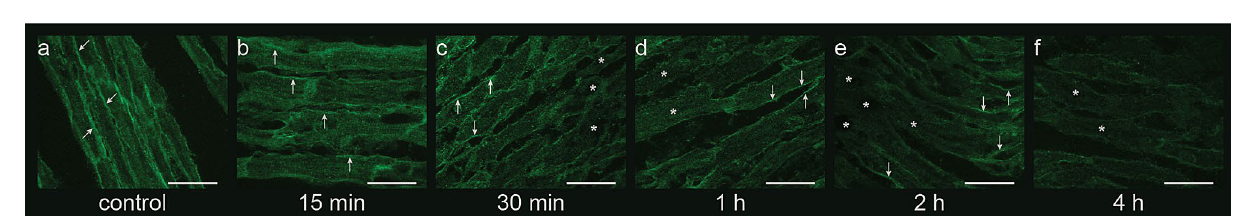
Figure 6. Immunofluorescence for Na v 1.5. ( a ) Expression of Na v 1.5 is evident at the plasma membrane and intercalated disks in the control heart; a fainter cytoplasmic signal was also observed. ( b ) Expression at 15 min of ischemia is similar to control. ( c – f ) Starting 30 min of ischemia, a patchy fainter expression was observed in the predicted ischemic region; asterisks (*) mark some of the cells and/or parts of cells with fainter signal at the plasma membrane and arrows indicate some of the cells with evident signal at the plasma membrane. The areas with fainter expression were more pronounced with prolonged ischemia with the strongest difference at 4 h; scale bar is 25 µm; n = 3 per time point (biological